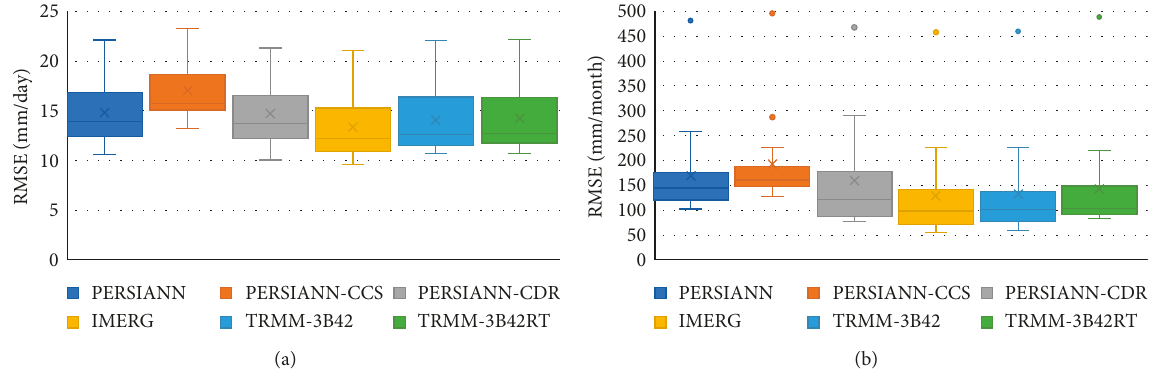
Figure 8: (a) For PERSIANN. (b) For PERSIANN-CCS. (c) For PERSIANN-CDR. (d) For IMERG. (e) For TRMM-3B42. (f) For TRMM- 3B42RT.